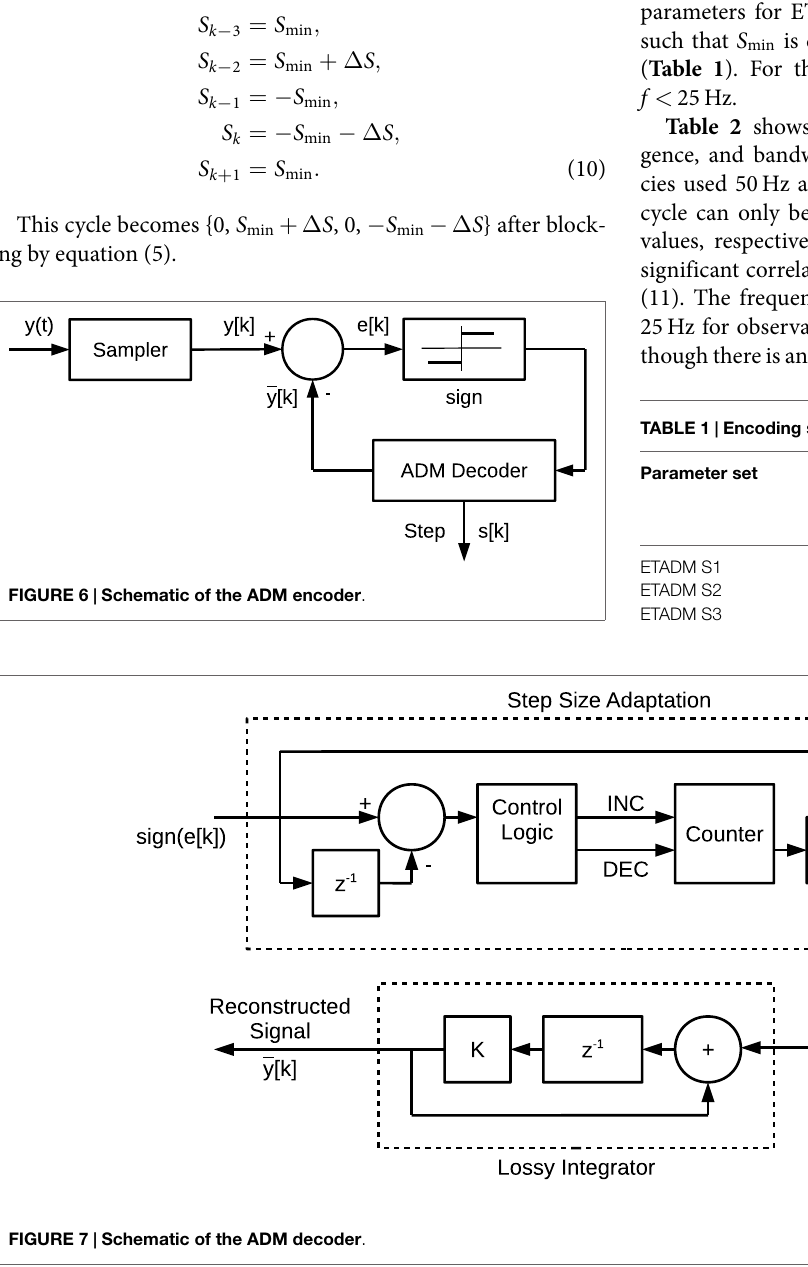
FIGURE 7 | Schematic of the ADM decoder